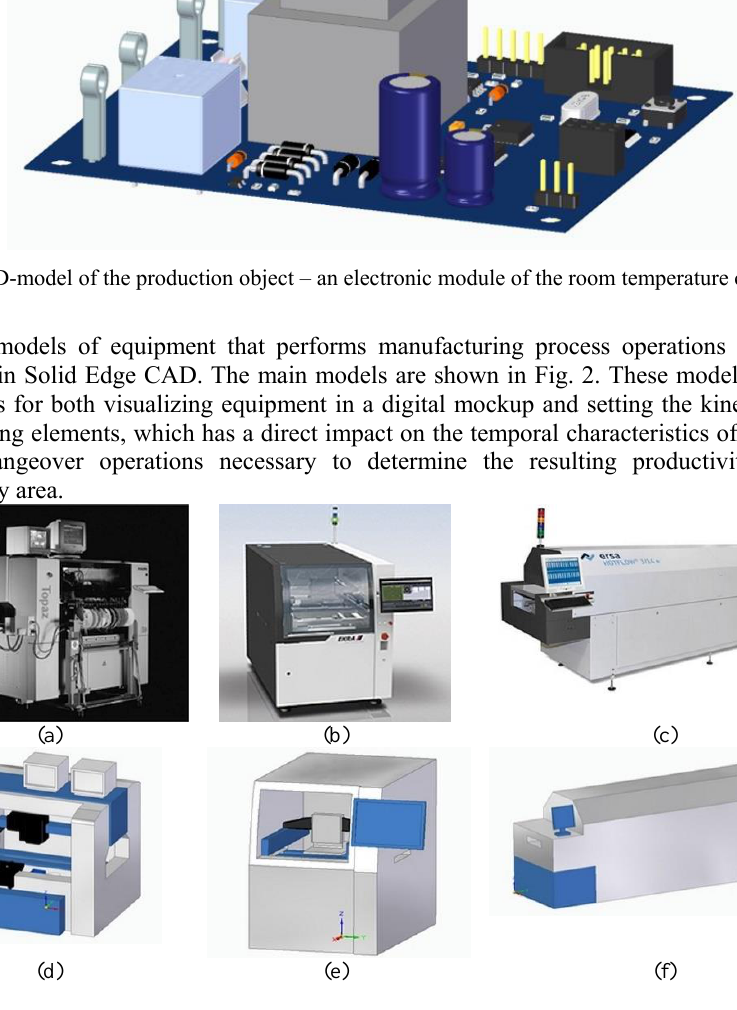
Fig. 2. General view and 3D CAD models of the main equipment for assembling electronic modules on printed circuit boards: (a), (d) component pick-and-place machine Philips Topaz; (b), (e) solder paste screen printing machine Erka X5 Professional; (c), (f) reflow oven Ersa HotFlow 3 / 14e.